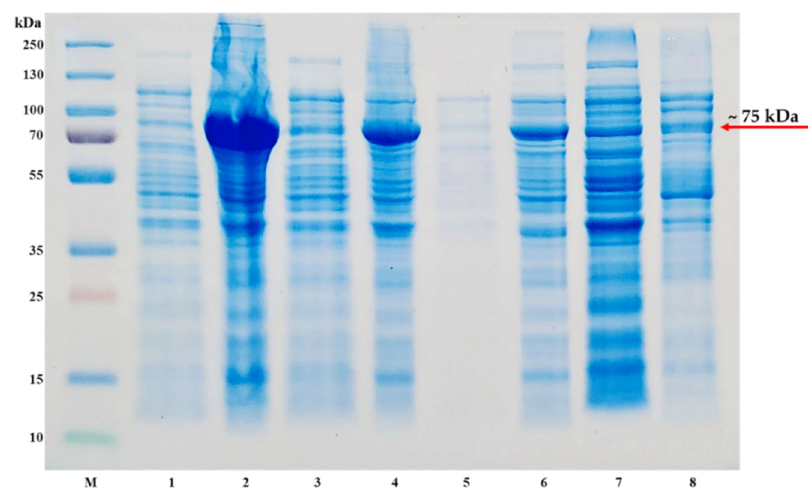
Figure 2. Expression of TP-coreSA fusion protein using different strains of competent cells. SDS-PAGE is imaged as ( M ) protein ladder, ( 1 ) NiCo21(DE3) soluble fraction, ( 2 ) NiCo21(DE3) pellets, ( 3 ) BL21(DE3) soluble fraction, ( 4 ) BL21(DE3) pellets, ( 5 ) SHuffle ® soluble fraction, ( 6 ) SHuffle ® pellets, ( 7 ) Lemo21(DE3) soluble fraction, ( 8 ) Lemo21(DE3) pellets.